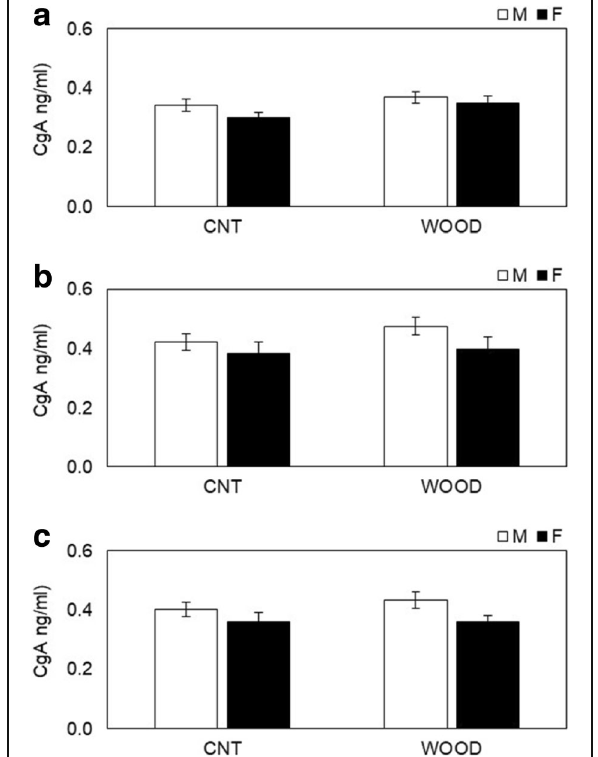
Fig. 4 Variation of salivary CgA levels changes a pre-, b during, and c post-experiment measurements. The bar in a – c describes changes in the salivary CgA levels of participants in the control condition (left) and Japanese cedar wood panels (experimental; light) conditions: male participants (white) and female participants (black). CNT indicates the control condition, while WOOD indicates the experimental condition. Differences between conditions were not significant. Data are shown as mean±SEM